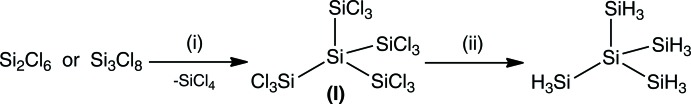
Amine-induced disproportionation of Si2Cl6 and Si3Cl8: (i) + NMe3, or NMe2Et, or NEt3 in benzene at room temperature; (ii) + LiAlH4 in diethyl ether at room temperature